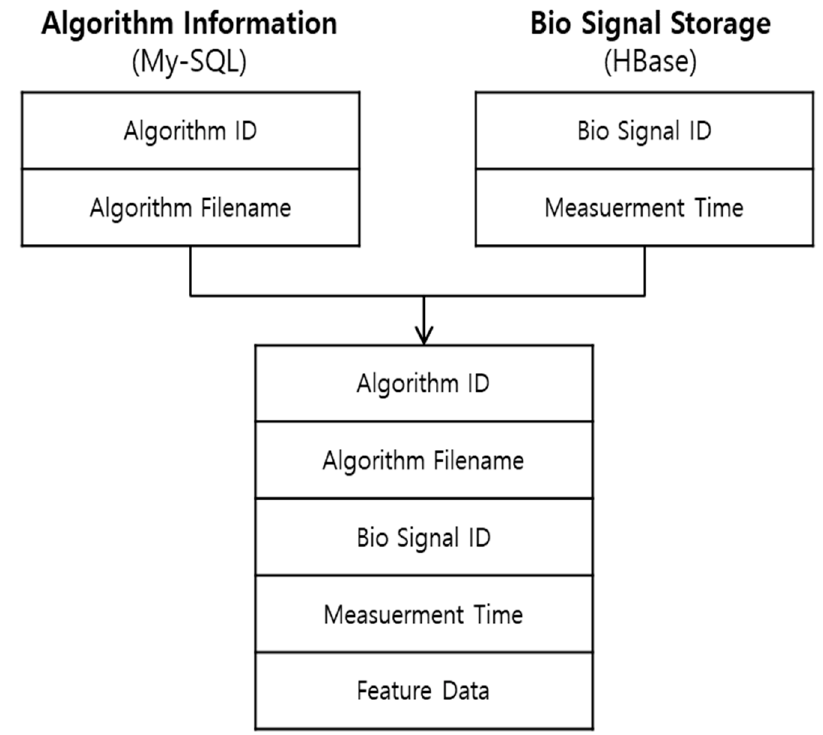
Figure 3. Design of data warehouse structure.